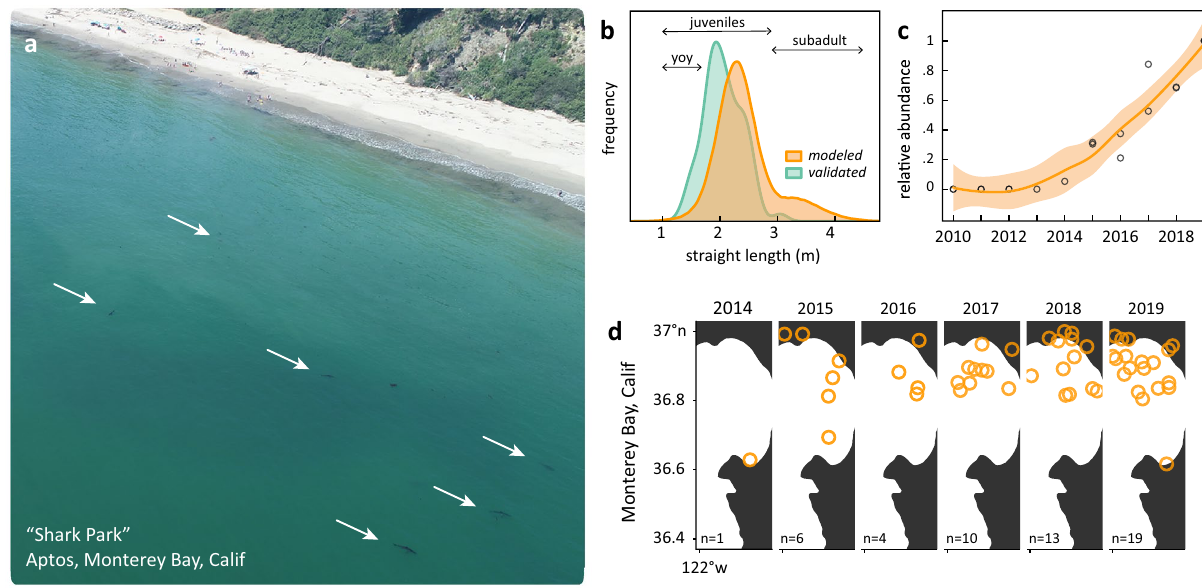
Figure 1. Juvenile white sharks became abundant in Monterey Bay during the 2014–2016 marine heatwave. a Aerial drone image detecting 6 small white sharks (denoted by white arrows) in September 2019 near Seacliff State Beach (36.97° N, 121.93° W). b Size composition from observer logbooks (n = 403) and photogrammetry validated measurements ( n = 65) indicate the vast majority of sharks in this area are juveniles, with fewer subadults, and a small minority of young-of-the-year (“YOY”). c , Ensemble time series of Juvenile and YOY white shark abundance in Monterey Bay, from observer logbooks and a community science project with iNaturalist. A smoothing spline (solid line, shaded area is SE) summarizes the trend of each rescaled series, showing a constant increase in abundance from 0 juvenile and YOY sharks before 2014 to a peak in 2019. d Mapped iNaturalist positions of juvenile and YOY white sharks show a concentration in northern Monterey Bay near